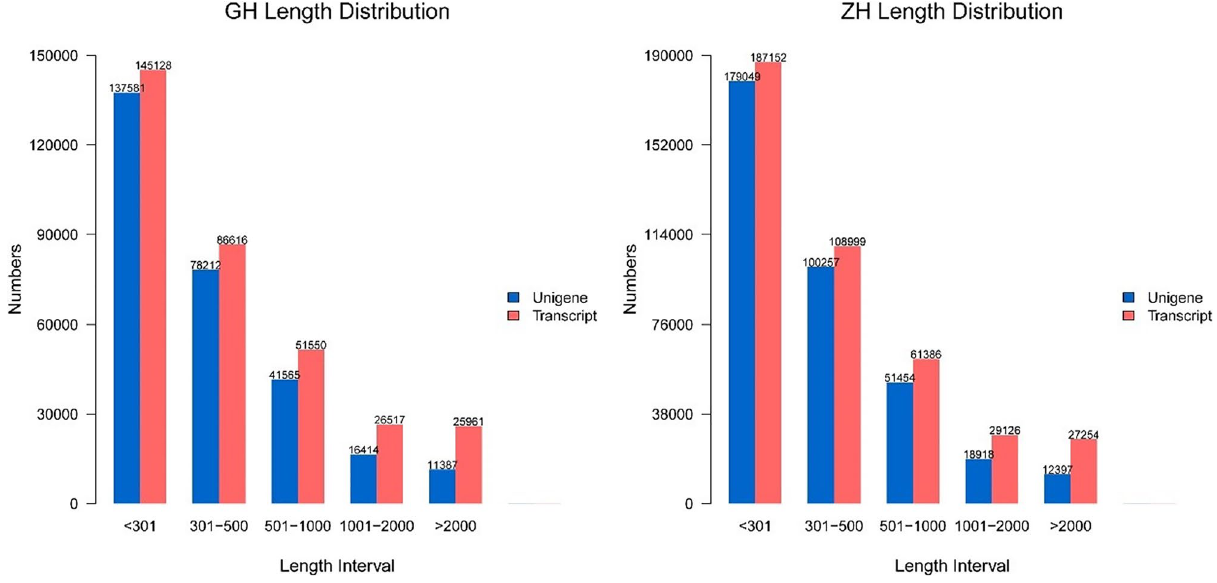
Figure 1. Length and quantity distribution of transcripts and